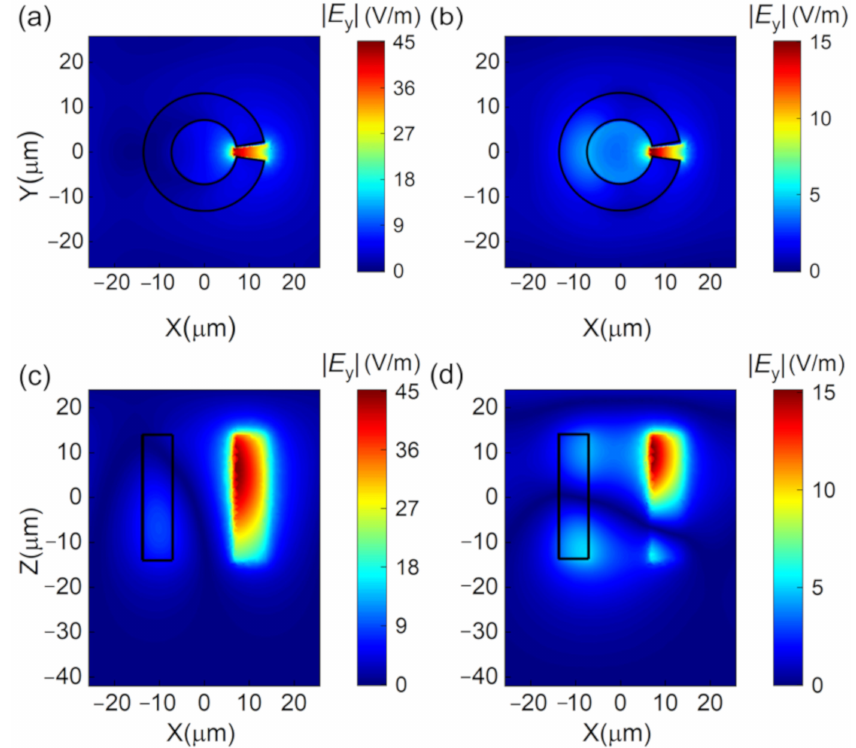
Figure 5. Electric field distribution of SRRs in the xy plane at ( a ) f 1 = 3.36 THz and ( b ) f 2 = 3.5 THz. Electric field distribution of SRRs in the xz plane at ( c ) f 1 = 3.36 THz and ( d ) f 2 = 3.5